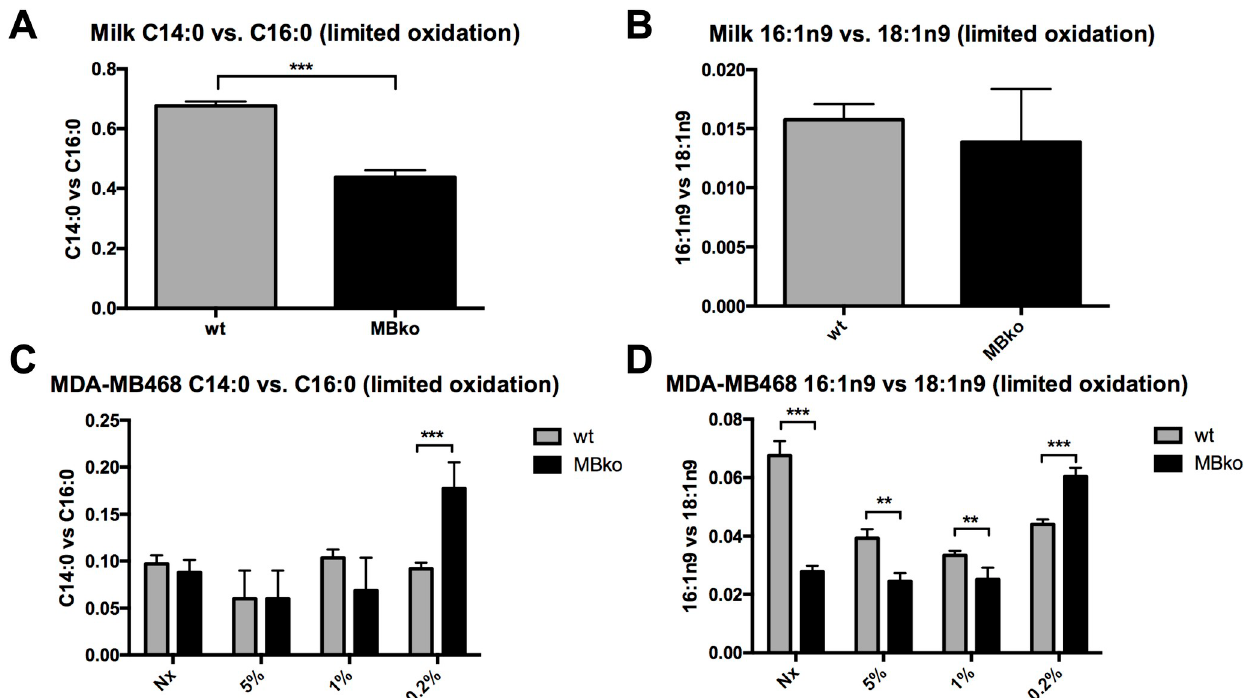
Fig 3. MB’s control of the limited oxidation of fatty acids. Limited oxidation was measured as C14:0 vs. C16:0 ratio or C16:1n9 vs. C18:1n9 ratio in mouse milk ( A, B ) and MDA-MD468 cells ( C, D ). In all graphs, MBwt as grey bars versus MBko black. MDA-MB468 cells were exposed to Nx, 5% O 2 , 1% O 2 (oxygenated MB) or 0.2% O 2 (deoxygenated MB). Students t-test was used for statistics (n = 4–8); mean ± SD. �� p � 0.005, ��� p � 0.001.